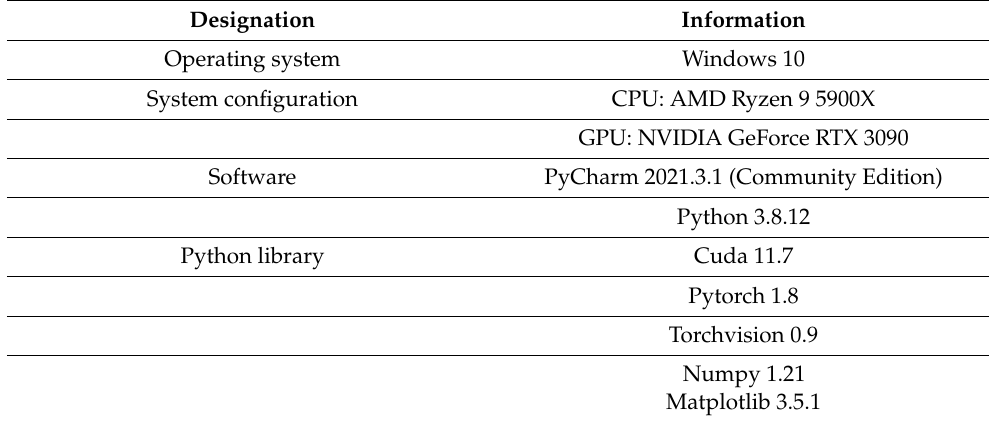
Table 2. Experimental environment